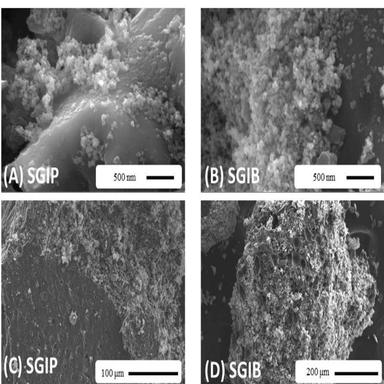
High-magnification SEM micrographs of (A) SGIP and (B) SGIB TiO2/AC heterostructures. Low-magnification SEM micrographs of (C) SGIP and (D) SGIB TiO2/AC heterostructures. Scale bars are shown.